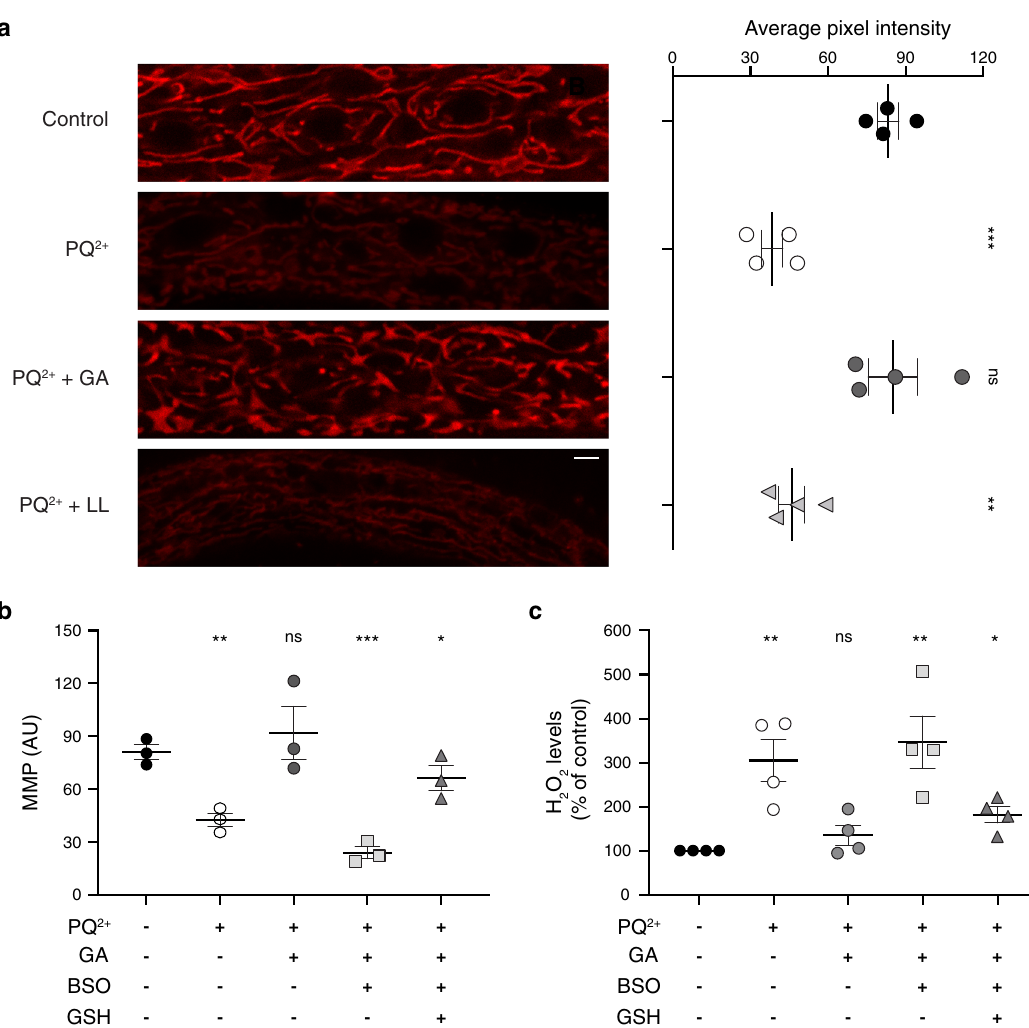
Fig. 1 Glycolate supplementation rescues mitochondrial membrane potential and counteracts oxidative stress of paraquat-treated worms through a glutathione-dependent mechanism. a Mitochondrial membrane potential ( ΔΨ m-MMP) after 2 days of PQ 2 + treatment supplemented or not with glycolate or L -lactate. Panels on the left display mitochondrial fl uorescence intensity (scale bar 10 µ m) with the corresponding quanti fi cation on the right ( n = 4). b Effect of inhibition of glutathione synthesis or glutathione supplementation on mitochondrial membrane potential ( n = 3). In a and b fl uorescence intensities were recorded after MitoTracker Red CMXROS staining. c H 2 O 2 levels in C. elegans worms treated in the same conditions as in ( b ). After 2 days of treatment, H 2 O 2 accumulation was measured with AmplexRed and fl uorescence intensity was normalized to protein levels ( n = 4). Error bars represent standard error of the mean. 200 μ M paraquat (PQ 2 + ), 10 mM glycolate (GA), 10 mM L -lactate (LL), 0.5 mM BSO, and 1 mM GSH were used as